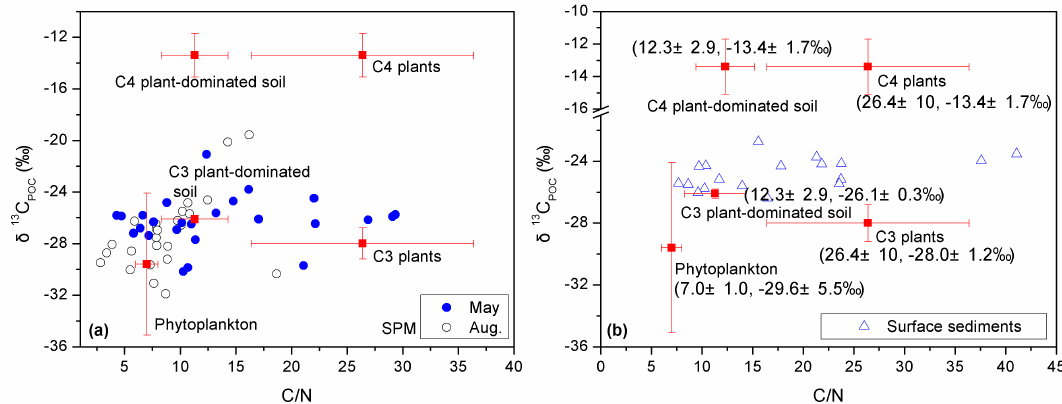
Figure 4. δ 13 C POC and C / N ratios of suspended and surface sediments in the Wujiang River. The isotopic and elemental compositions of different end-members are taken from Li (2009), Wu et al. (2007), and Tao et al. (2009) and references